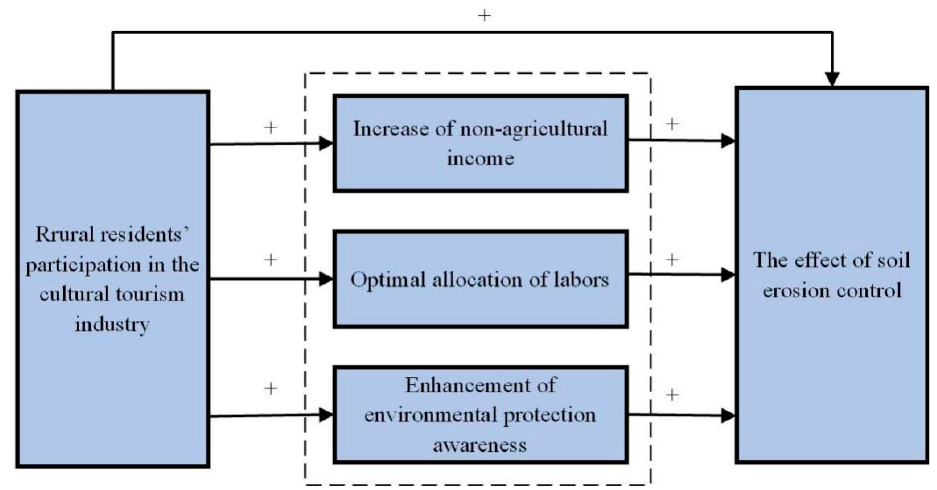
Figure 1. The theoretical framework used in the current study.